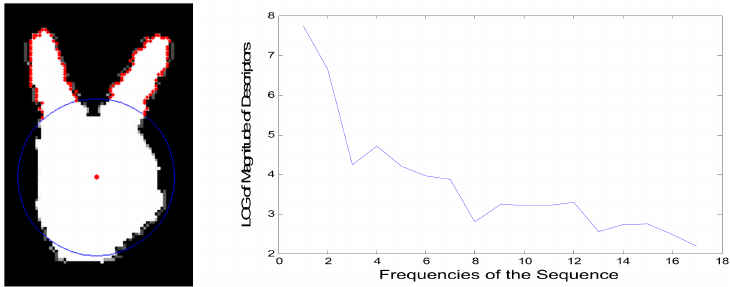
Figure 4. The fingers and distribution of FF descriptor vs.